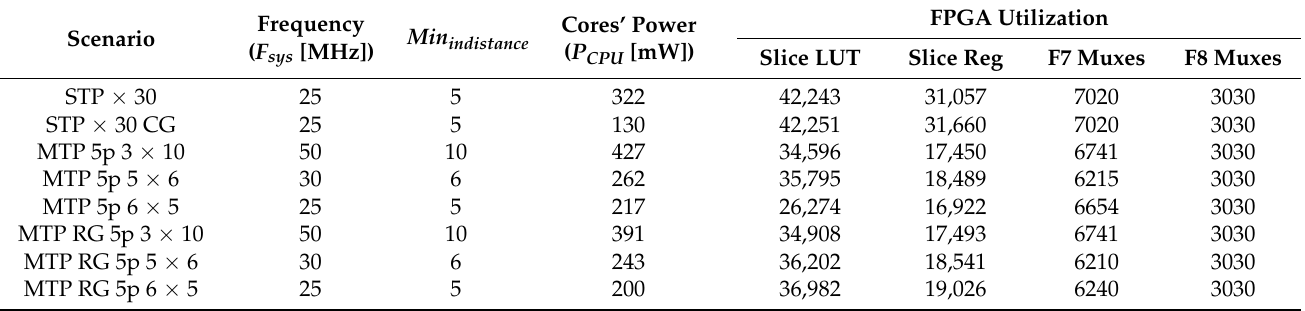
Table 3. Results obtained for different systems with the same productivity: SP = 150.